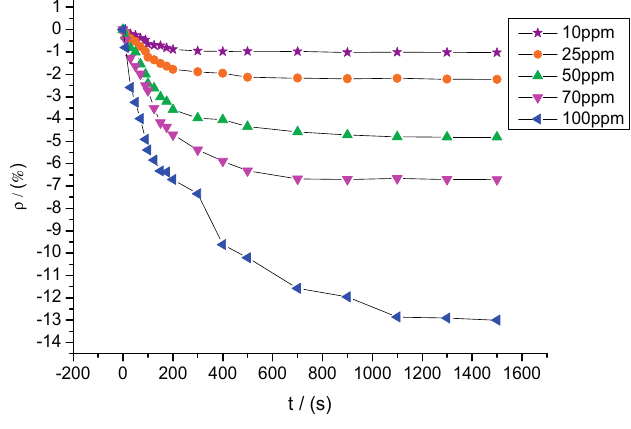
Figure 13. Gas-sensing response of MWNT sensors to different concentrations of SOF 2